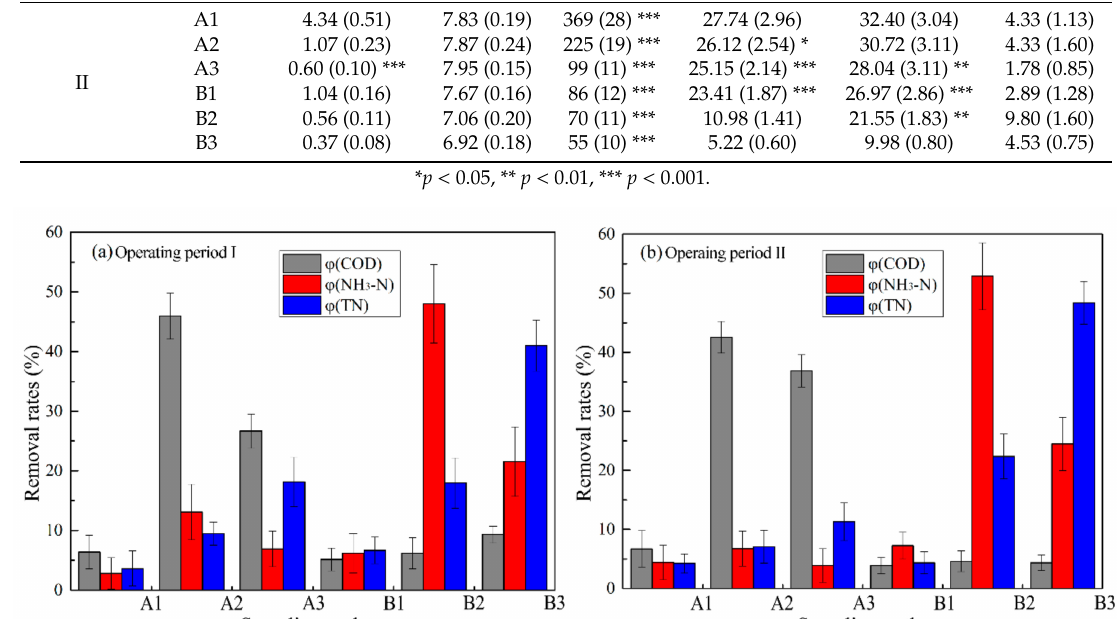
Figure 2. Comparison of pollutant removal rates along the filter under two organic loads. ( a ) Operating period I; ( b ) Operating period